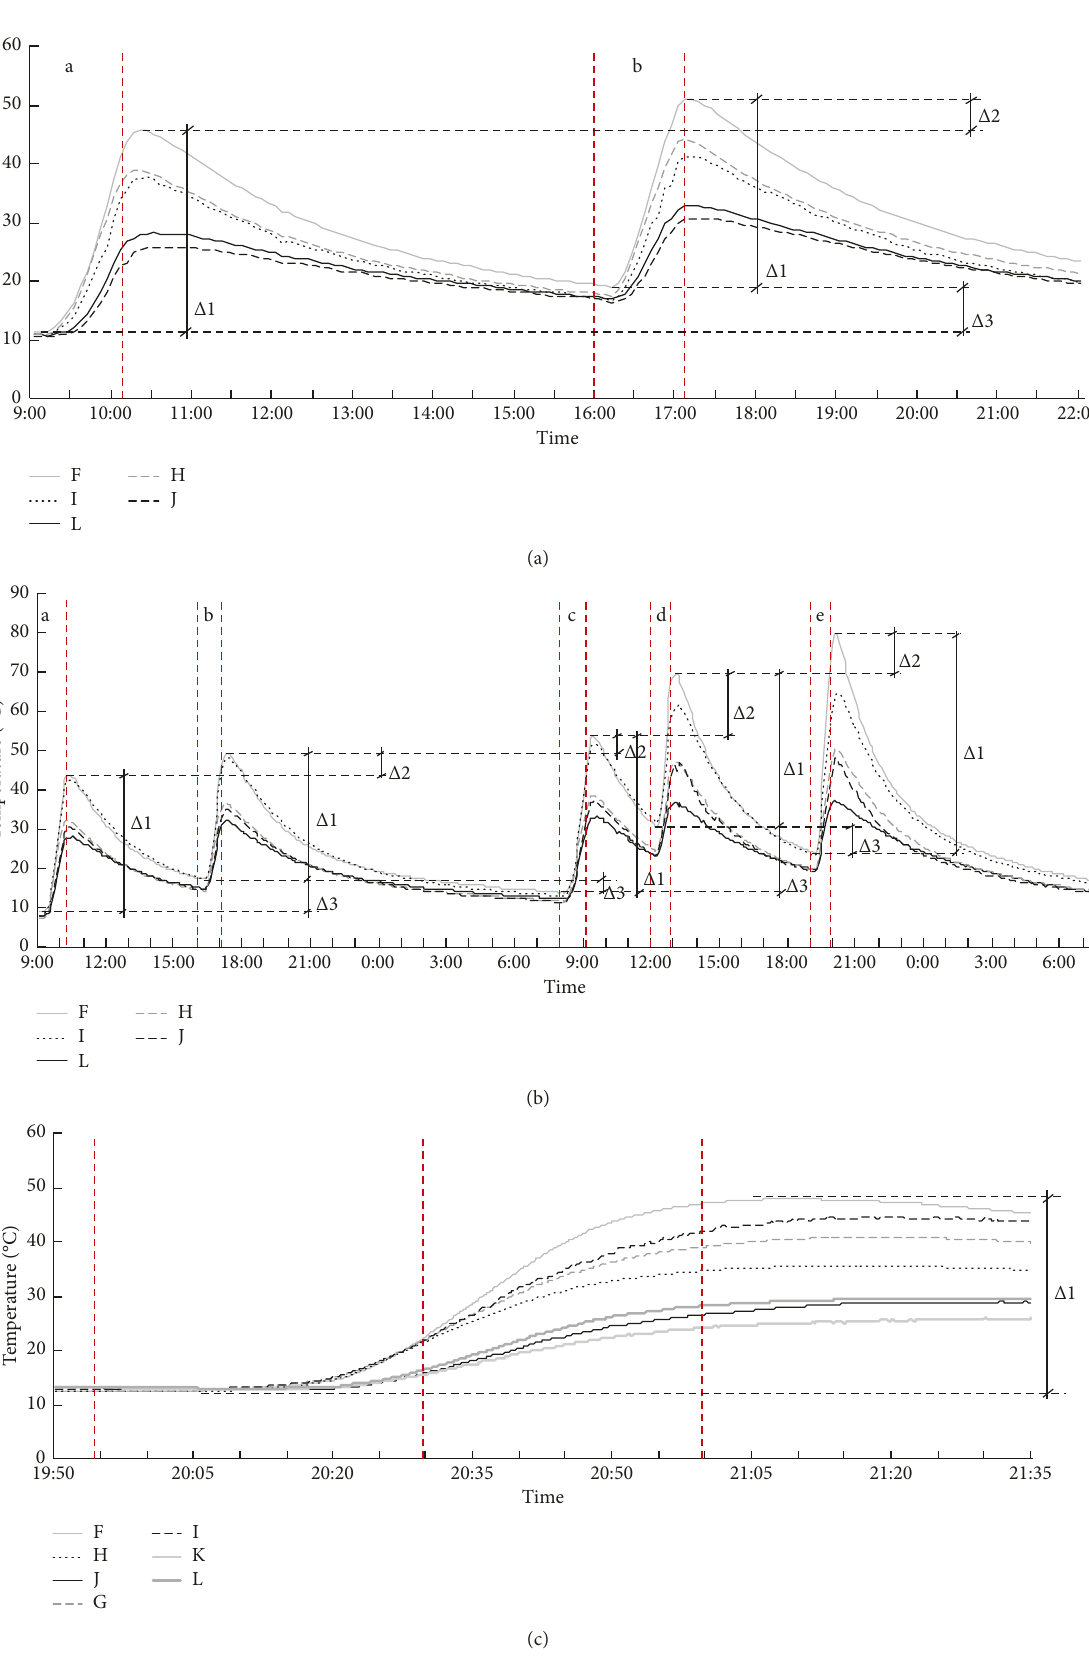
Figure 9: Heated wall temperature distributions: (a) Test 1, (b) Test 2, and (c) Test